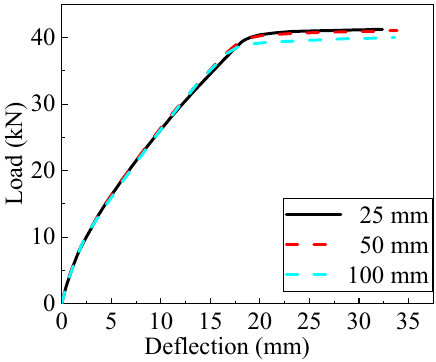
Figure 14. Mesh analyses results for the AACP.